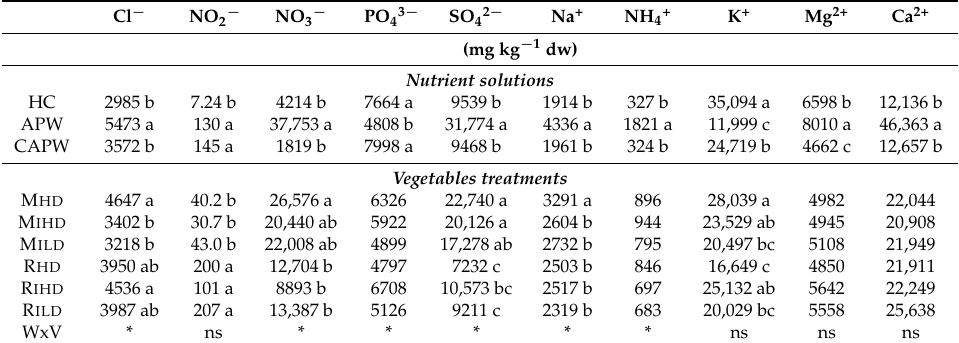
Table 5. First growth cycle: Effect of water and vegetable treatments on the ion concentrations.